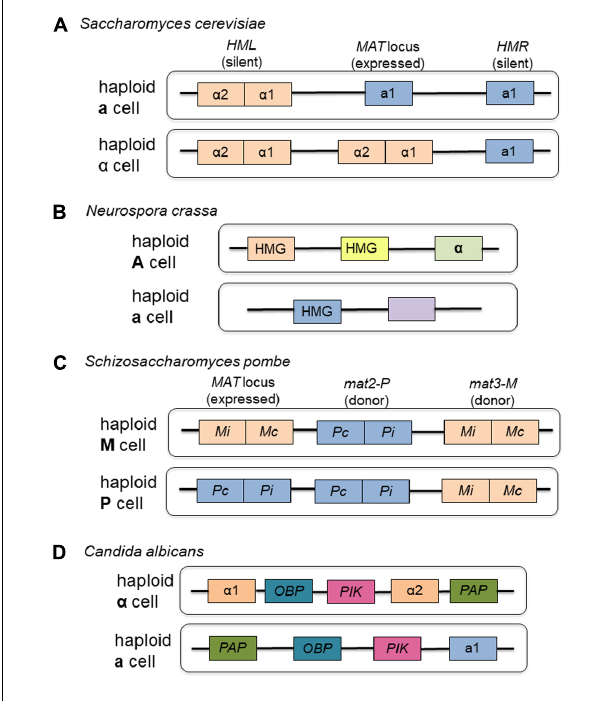
FIGURE 2 | Representative mating type loci from the Ascomycota. (A) The organization of the mating-type loci of Saccharomyces cerevisiae serves as the model for the group, containing homeodomain proteins that regulate the expression of other mating type-specific genes. (B) Although not as well characterized as Sa. cerevisiae , Neurospora crassa exists as two haploid mating types, each of which contain genetic information at the mating type loci to govern expression of mating type specific genes. (C) Like Sa. cerevisiae , Schizosaccharomyces pombe contains homeodomain proteins at its mating type loci consisting of both expressed and donor regions. (D) Although most clinical isolates are diploid, Candida albicans does have two different mating type loci found in two haploid strains that can be cultivated in the laboratory setting. Boxes of the same color represent corresponding components in the different mating